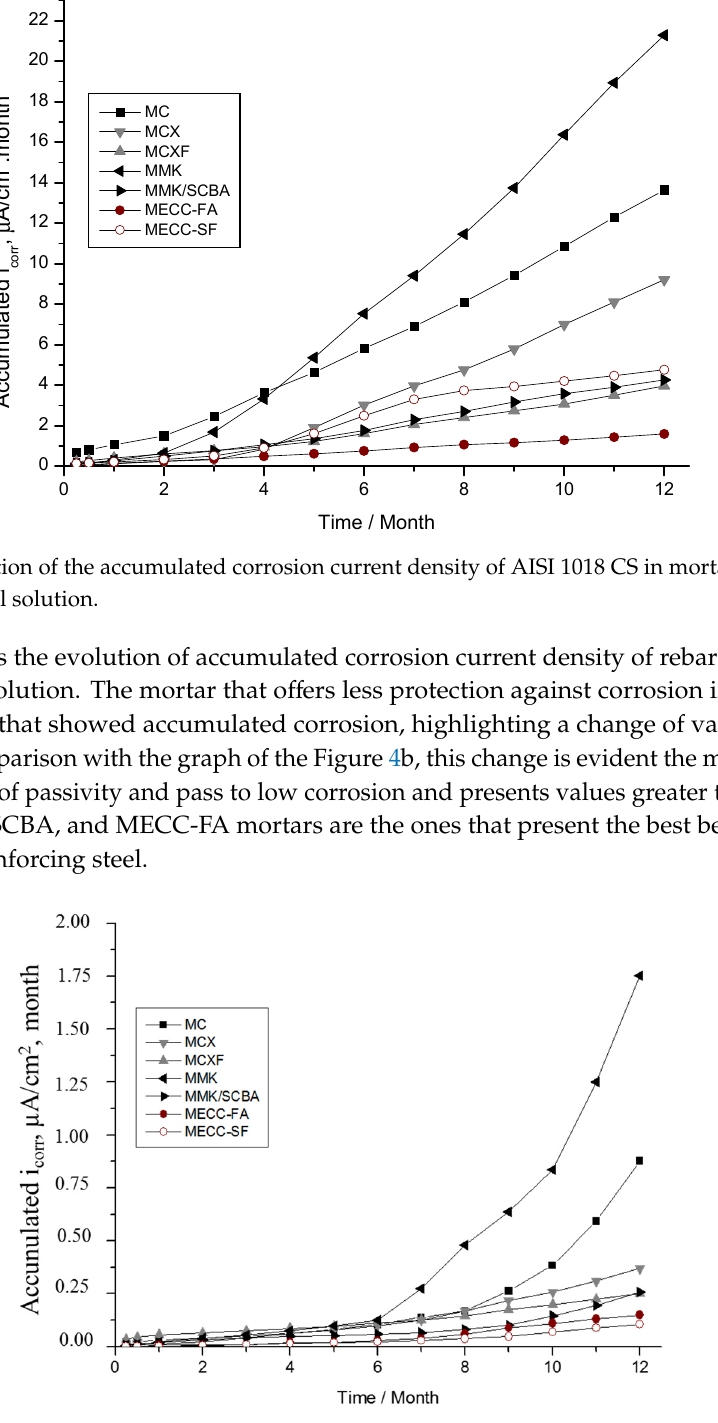
Figure 6. Evolution of the accumulated corrosion current density of AISI 1018 CS in mortars, exposed in 3.5 wt % Na 2 SO 4 solution. in 3.5 wt % Na 2 SO 4